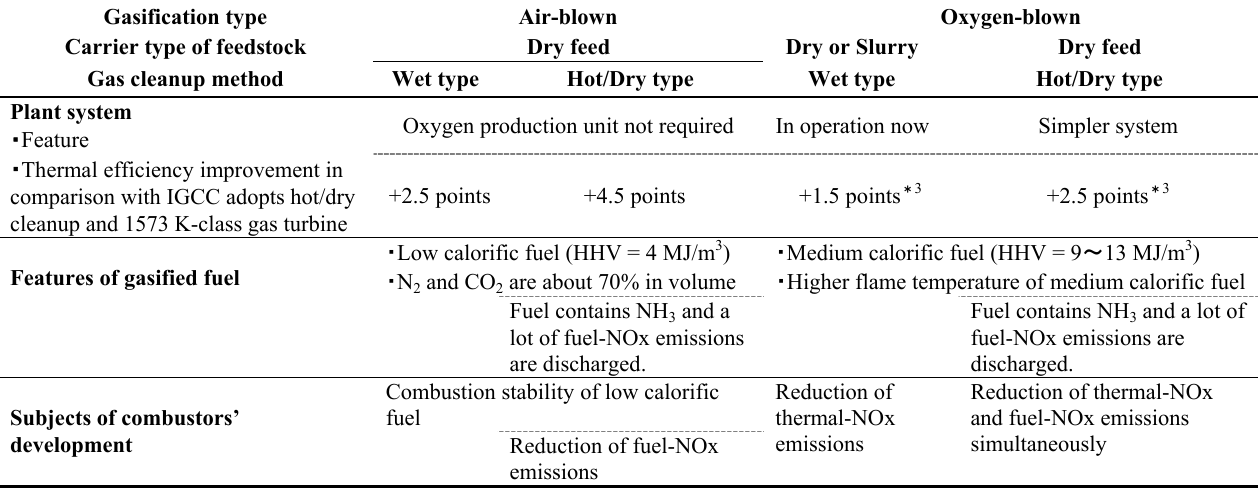
Table 10. Summary of each low-NOx combustor and non-catalytic reduction of NH gasified